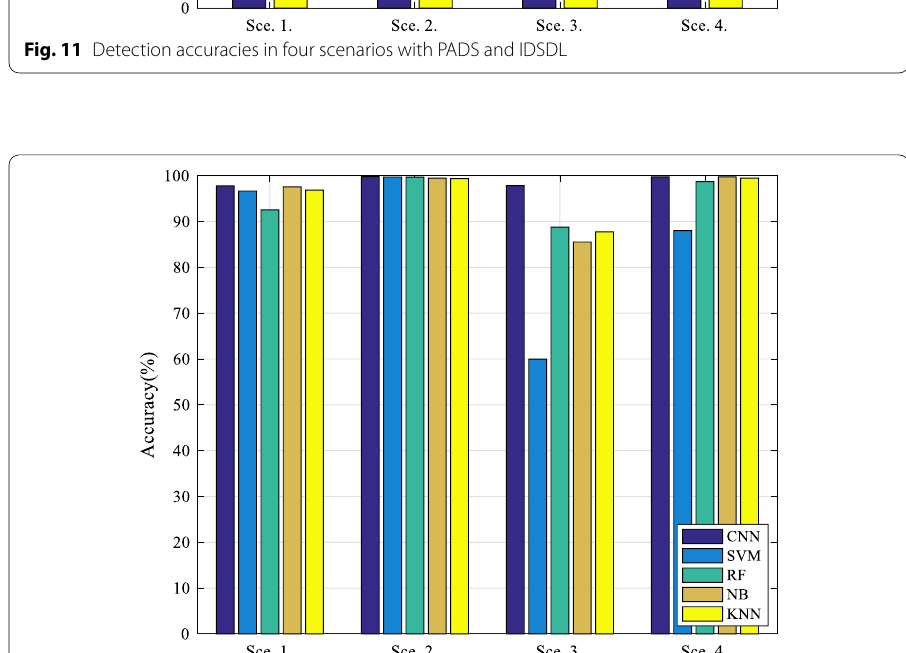
Fig. 12 Detection accuracies in four scenarios by using CNN, SVM, RF, NB and